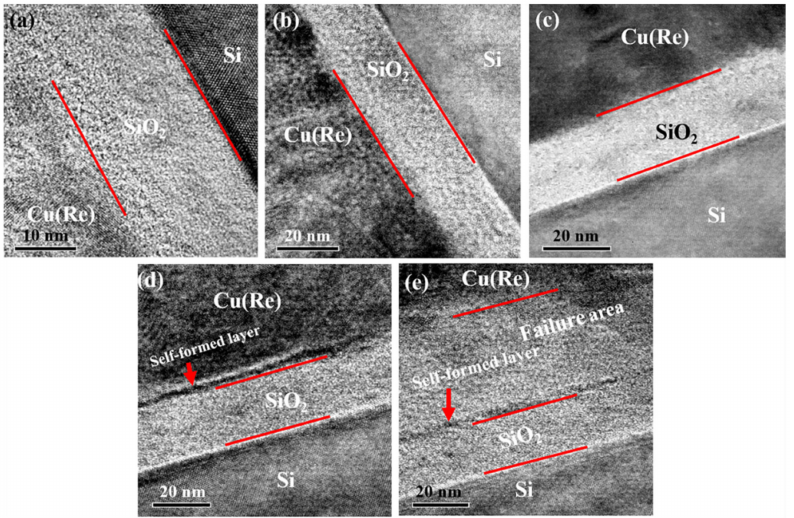
Figure 3. High-resolution image of the Cu(Re)/SiO 2 /Si interconnect structure at various tempera- tures: ( a ) as-deposited, ( b ) 350 ◦ C, ( c ) 450 ◦ C, ( d ) 550 ◦ C and ( e ) 650 ◦